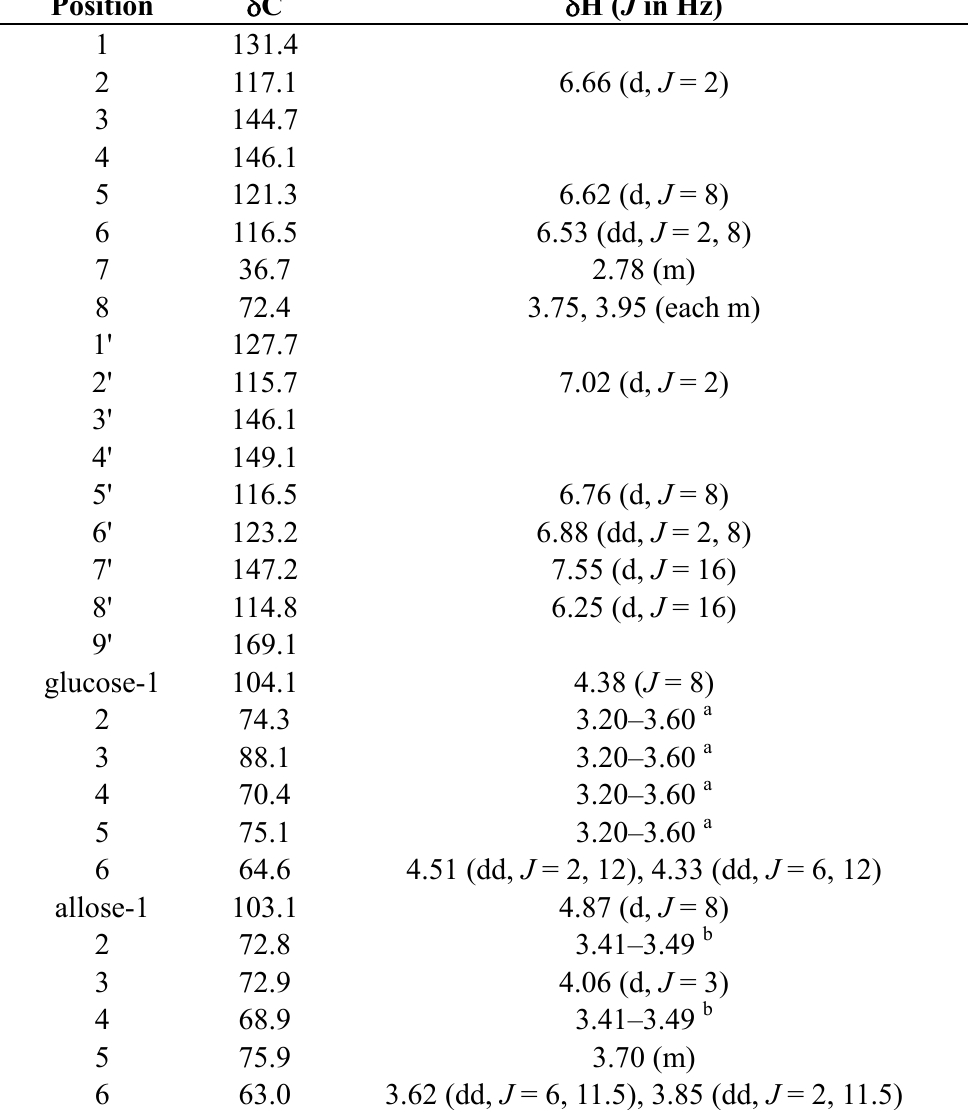
Table 1. 1 H- (500 MHz) and 13 C-NMR (126 MHz) data of compound 7 measured in MeOH- d